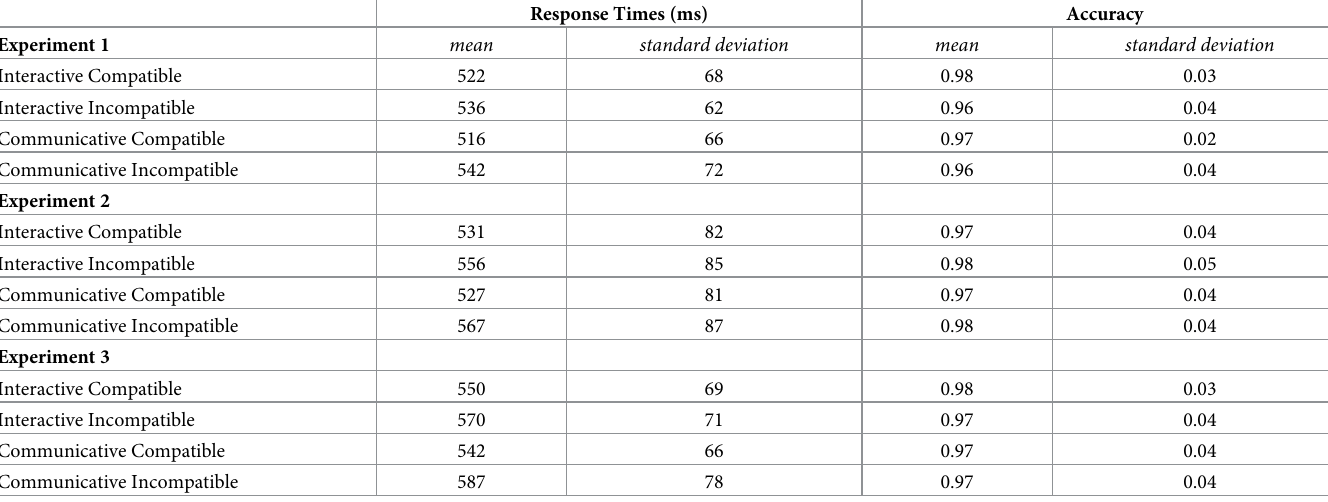
Table 1. Raw group means of Acc and RTs in each experimental condition for the three